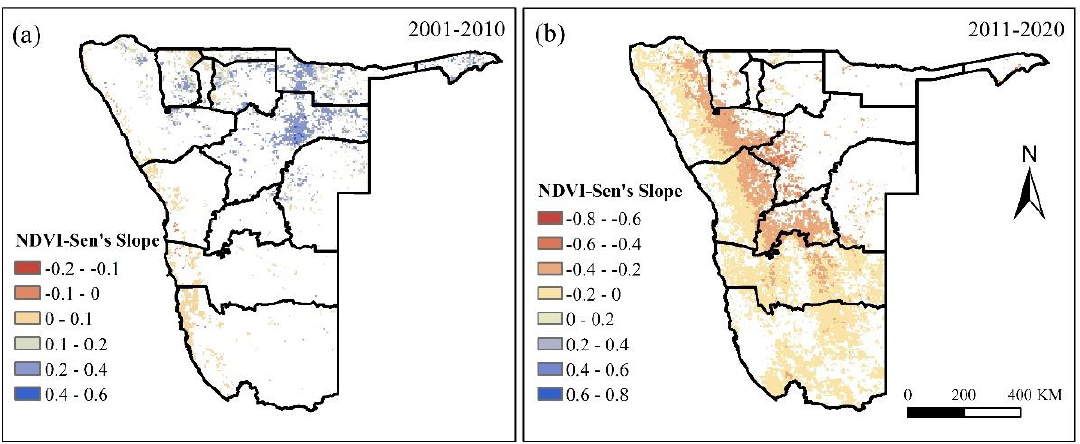
Figure 3. Spatial variation trends in cumulative NDVI during the growing season in Namibia for ( a ) 2001–2010 and ( b ) 2011–2020. Areas without significant trends are shown in white.